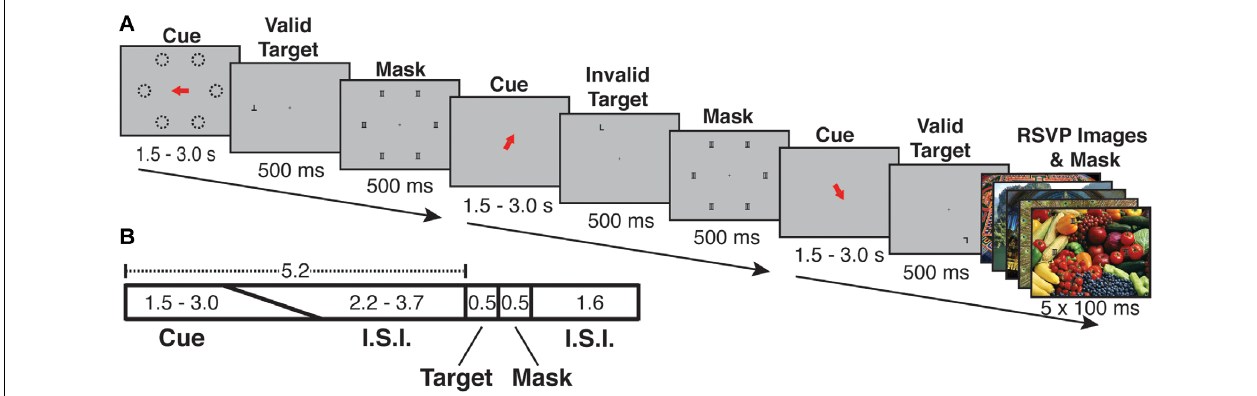
FIGURE 1 | Cue-ball task trial structure and timing. (A) Examples of each of three trial types (Valid, Invalid, Oddball). Each trial began with a spatial cue indicating one of six possible locations (dashed lines in A , dashed lines were not visible during the experiment). Following an inter-stimulus interval, the target appeared. The target was the letter “T” or “L” and could appear upright or inverted. The cue could be valid (target appears at the cued location) or invalid (appears in an uncued location). Following the target, a mask of superimposed “T”s and “L”s was presented at all possible target locations. On a randomly selected 1/6 of trials, a task-irrelevant RSVP stream of five vivid, full-screen, session-unique “oddball” images appeared behind the letter mask, each with 100 ms duration. (B) Trial timing: the orienting phase was 5.2 s in total, with cue duration randomly jittered from 1.5 to 3.0 s and the fixation cross ISI accounting for the remaining 5.2 s. Following the orienting phase, the target appeared for 500 ms, followed by the mask or oddball mask for 500 ms. The mask/oddball phase was followed by an inter-trial interval of 1.6 s. Participants were asked to indicate the identity of the target letter (T or L).